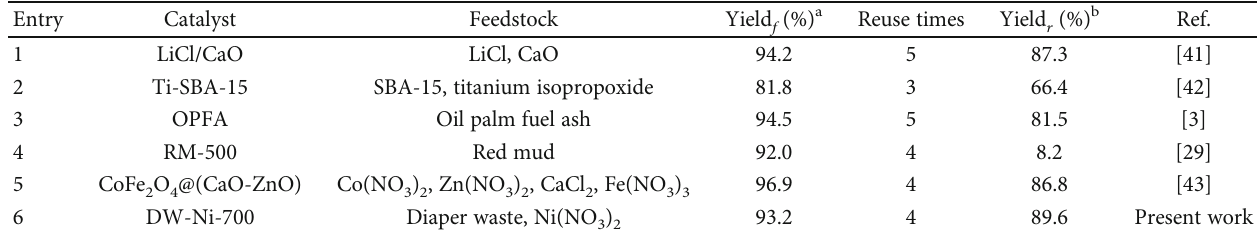
Table 2: Comparison of the DW-Ni-700 with reported heterogeneous